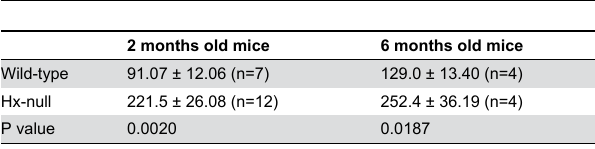
Table 1. Hx deficiency results in increased iron deposits in the